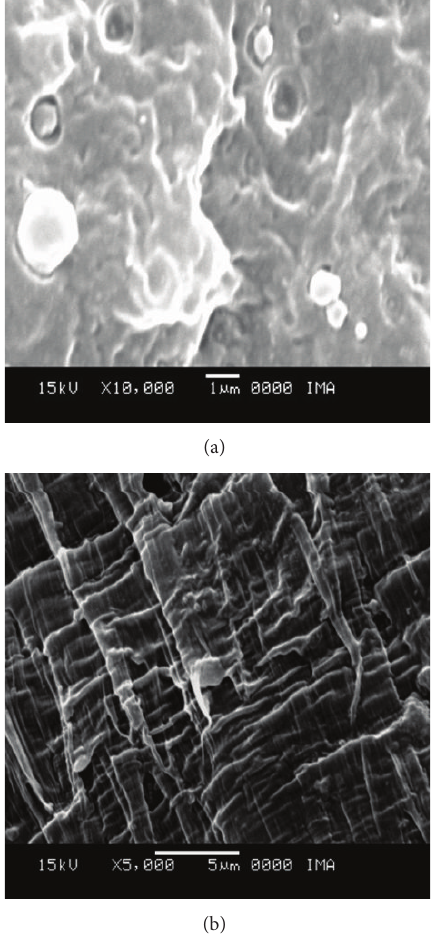
Figure 2: SEM (a) images of HDPE/MMT (a) and 2wt%